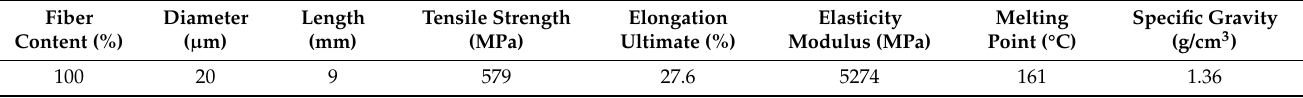
Table 2. Properties of polypropylene fiber.